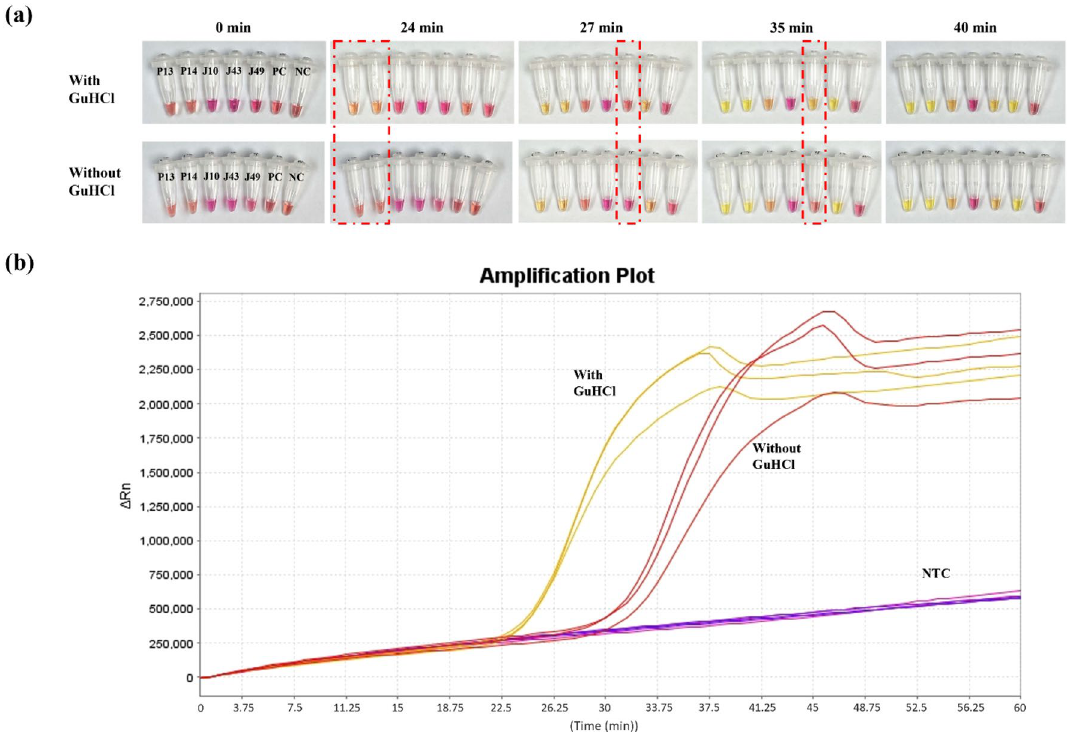
Figure 3. Testing the effect of adding 40 mM guanidine hydrochloride (GuHCl) in ( a ) colorimetric RT-LAMP reaction on positive clinical samples (P13, P14, J10, J49) and an inconclusive sample (J43). This addition improved the detection time in one sample (J49), where it started to change color 8 min earlier compared to reactions without GuHCl. The inconclusive sample J43, however, remained negative in both. The red dashed rectangle highlights the samples having an earlier color change to yellow with the GuHCl addition at the same reaction time. ( b ) Fluorometric RT-LAMP PC and NTC triplicate test with and without GuHCl. All PC triplicates with GuHCl amplified earlier than those without. There were no amplifications in NTC in both colorimetric and fluorometric tests, suggesting that GuHCl enhances the detection speed without causing misamplification in the